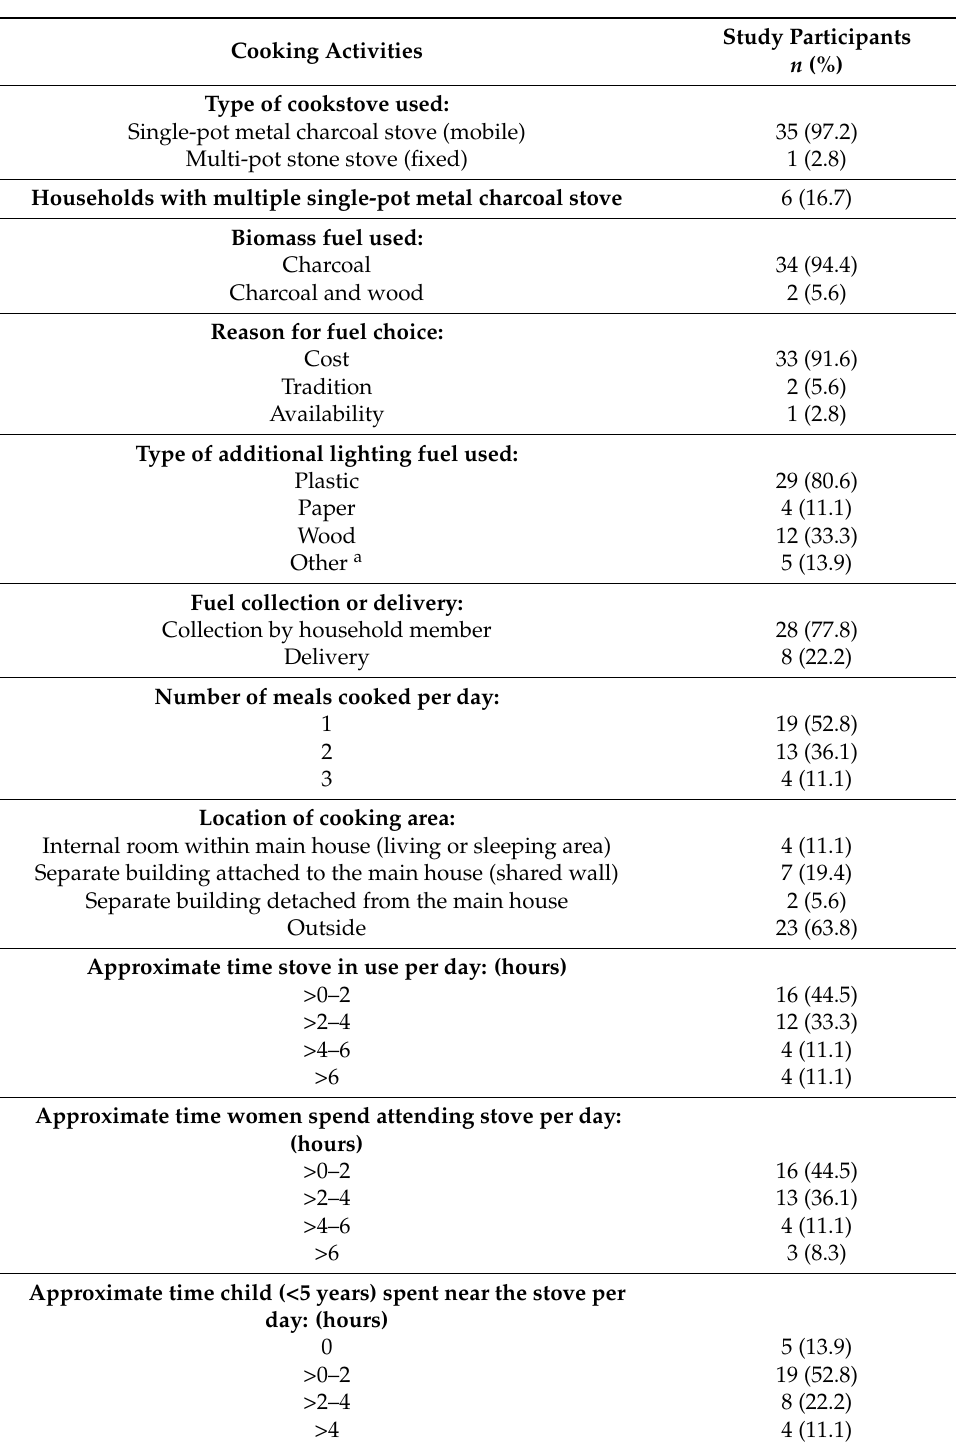
Table 2. Cooking activities and preferences ( n =